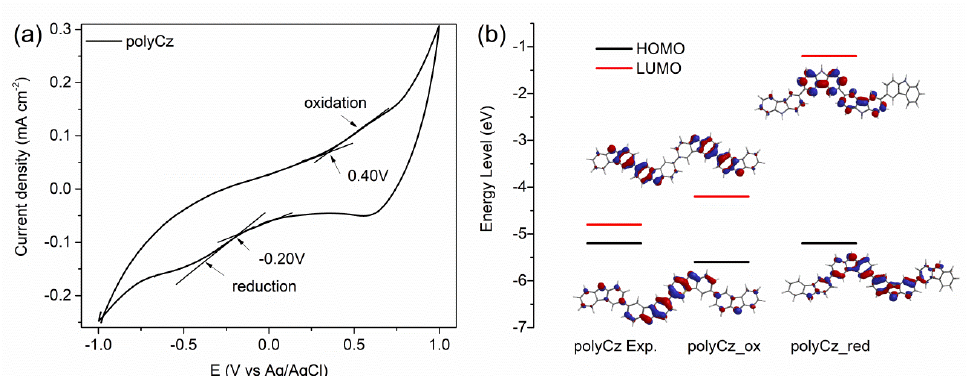
Figure 2. Comparison experimental and theoretical energy levels of polyCz: ( a ) cyclic voltammogram of the polyCz electrode in 0.1 M phosphate-buffered saline solution (PBS) (pH 7.4) at sweep rate of 50 mV·s −1 ; ( b ) experimental and theoretical energy levels and visualization of their orbitals (isovalue = 0.032) of polyCz.